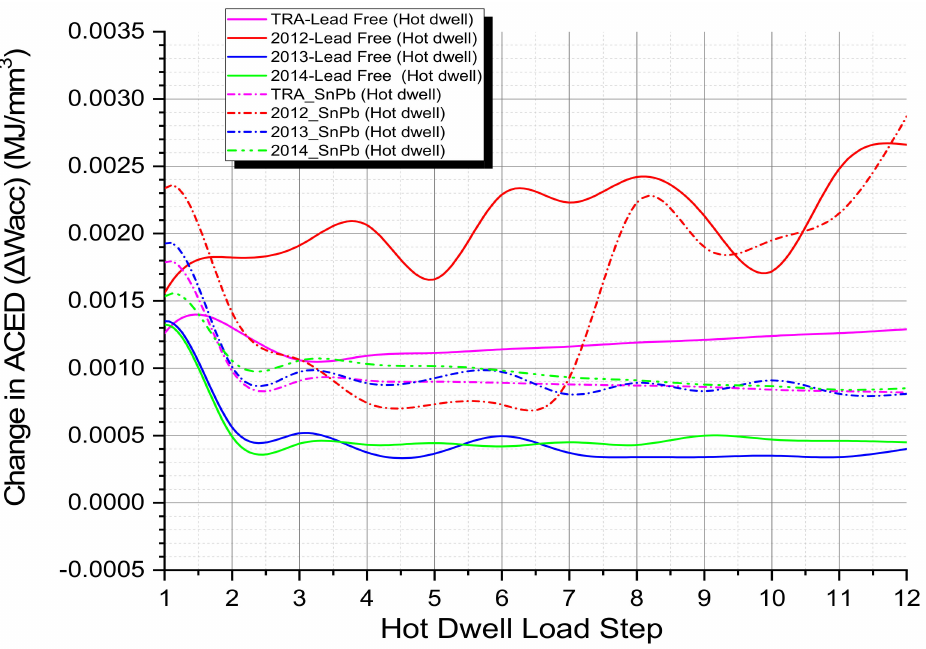
Figure 11. ACED damage accumulation from hot dwell load